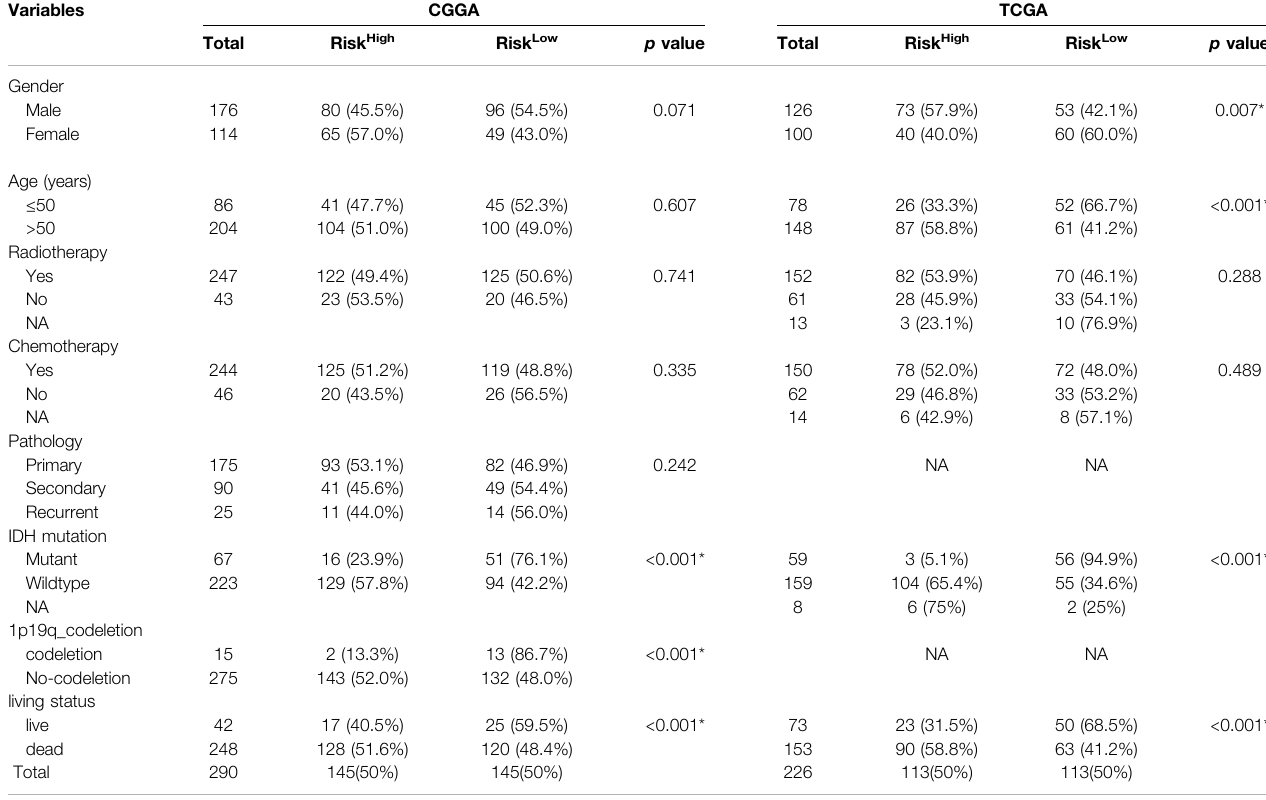
TABLE1 | Baseline information of patients with glioma in CGGA and TCGA.